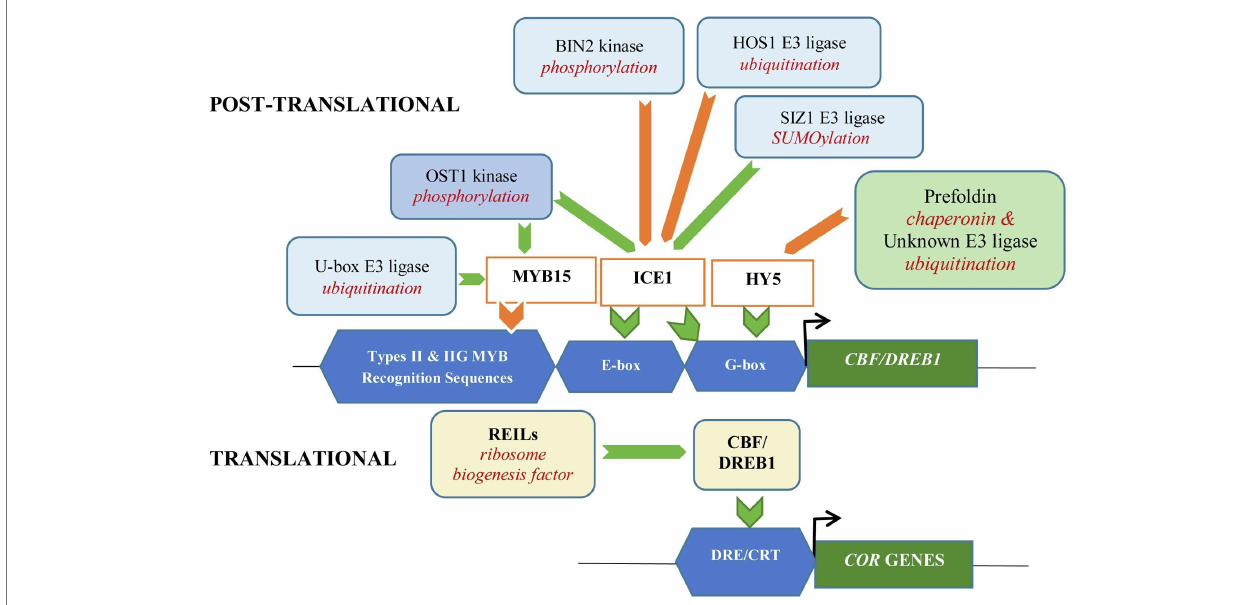
FIGURE 2 | Translational and post-translational modifications of transcription factors affecting CBF-dependent signaling for cold acclimation in Arabidopsis thaliana . Translational regulation by ribosome biogenesis factor, REILs increase rRNA processing and CBF levels, positively affecting cold acclimation. Post- translational regulation through ubiquitination for proteosomic degradation of ICE1 (positive regulator of CBF) is suppressed by SUMOylation involving SIZ1 E3 ligase. Phosphorylation of ICE1 by OST1 disrupts its interaction with HOS1 E3 ligase preventing degradation of ICE1 and enhancing cold tolerance. While under prolonged cold stress, phosphorylation of ICE1 by BIN2 kinase facilitates interaction of ICE1 and HOS1 and subsequent degradation of ICE1. Phosphorylation of U-box E3 ligase (PUB25 and PUB26) by OST1 increases ubiquitination and degradation of the negative regulator MYB15 in Arabidopsis, enhancing the expression of CBF and its regulons, COR GENES. In contrast, promotion of ubiquitination of the positive regulator, HY5 through interaction with prefoldin which acts as a molecular chaperon, suppresses CBF expression. Green and orange arrows represent reactions/interactions that provide positive and negative effects, respectively, on the signaling pathway and expression of COR